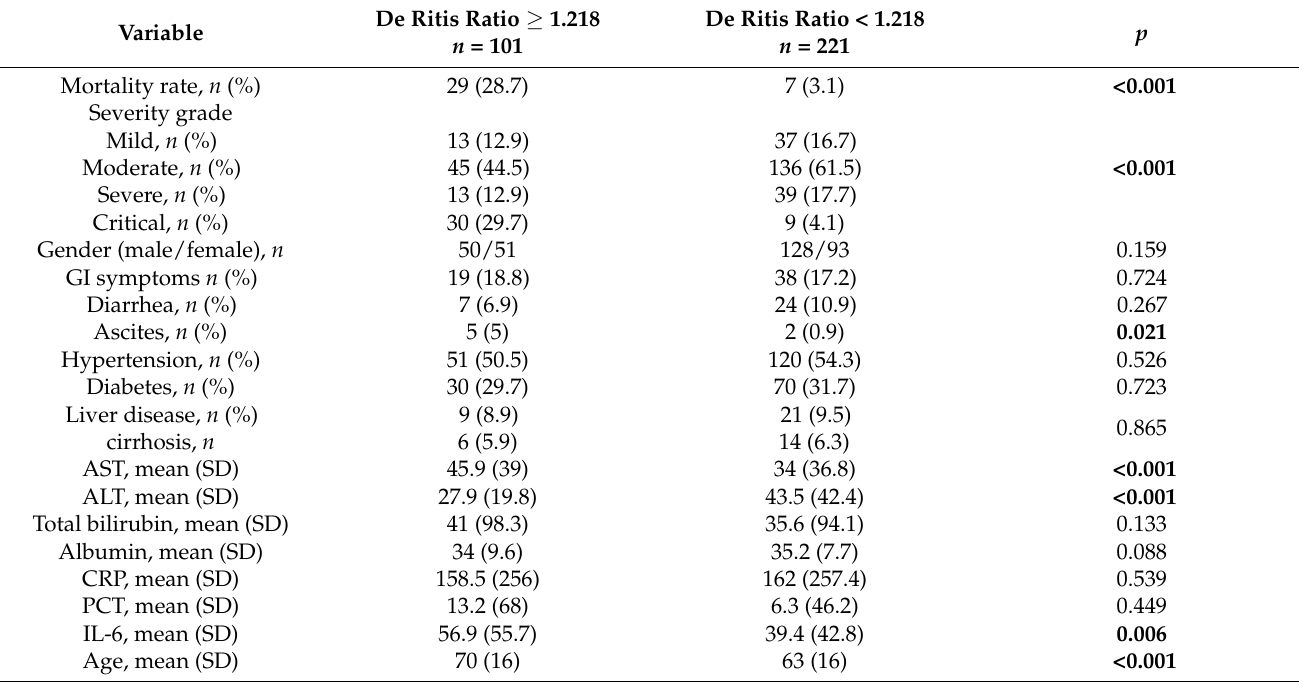
optimal cut-off value of the De Ritis